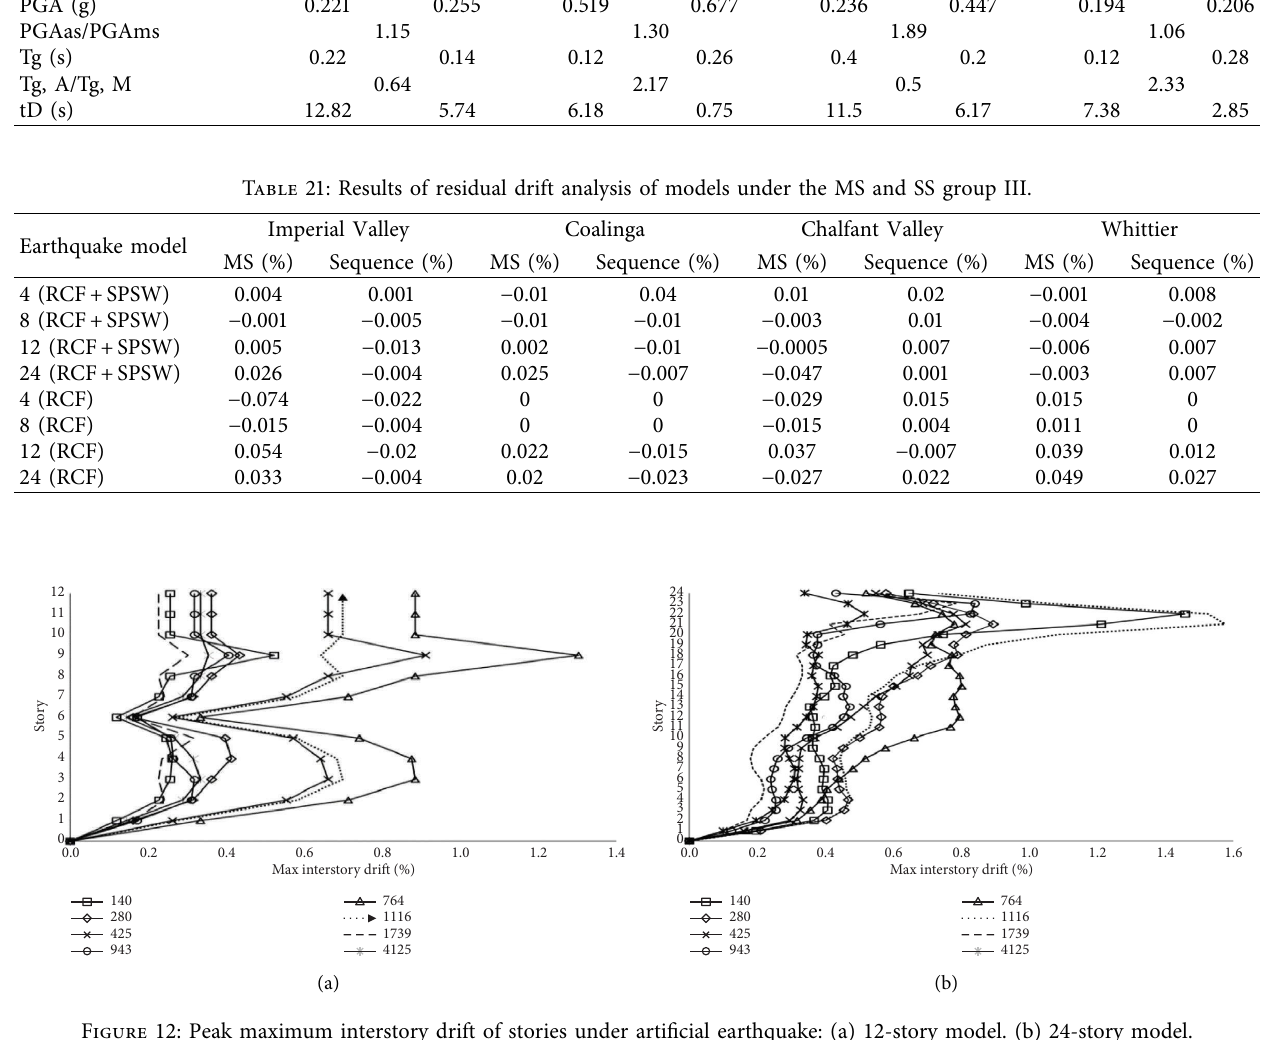
Table 20: Parameters and efective characteristics in the response of models under group III. Earthquake parameter